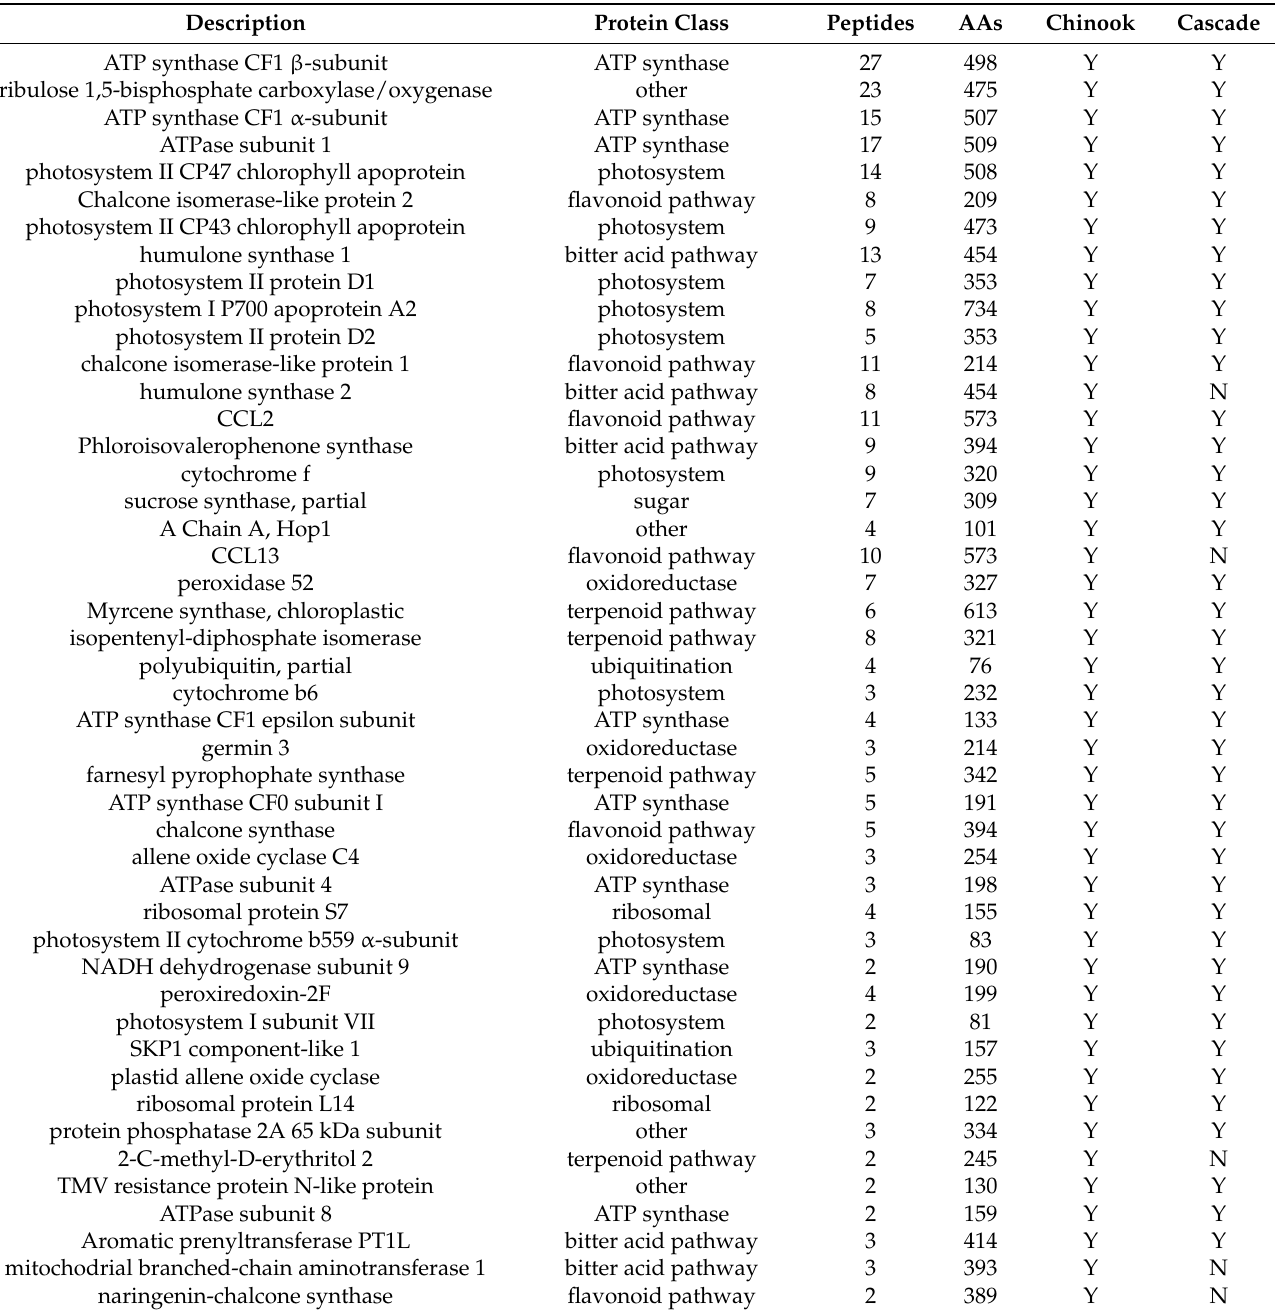
Table 3. Proteomic list in the hop